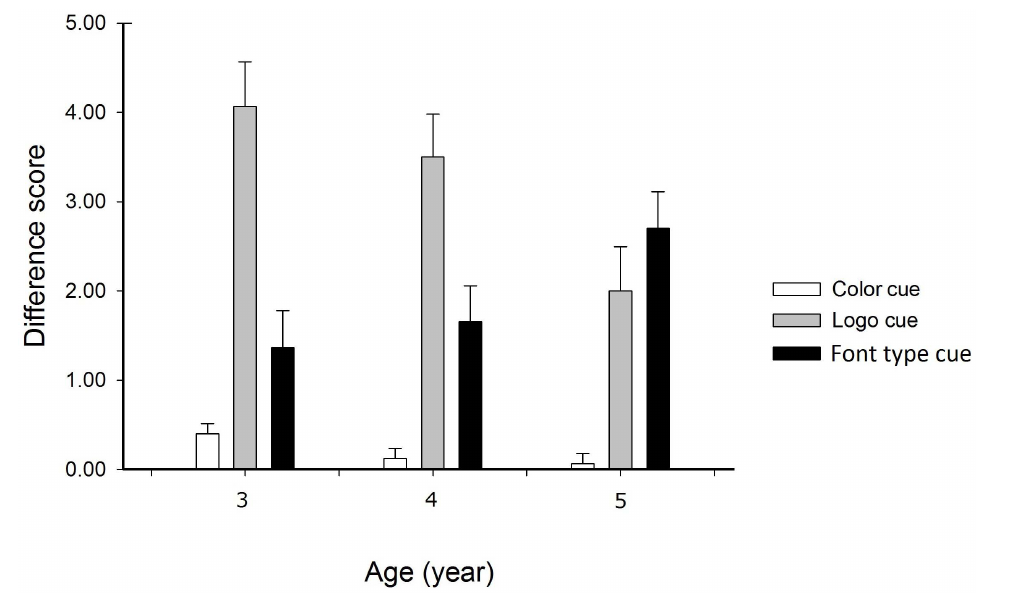
Figure 2. Difference scores between two versions in children at ages of 3, 4, and 5. Children at different ages showed various degrees of dependence on the cues to read words contained in environmental prints. The influence of the color cue and the logo cue was stronger in children aged 3 and 4 than those aged 5, while the role of the font type cue was stronger in the 5-year-olds than those aged 3 and 4.